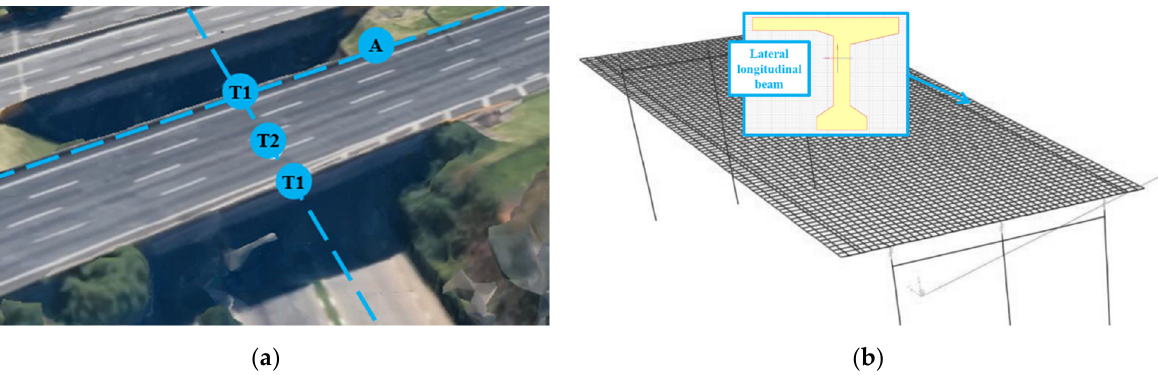
Figure 1. Brazilian bridge: ( a ) photo with the position of the sensors; ( b ) FEM model of the whole bridge and the lateral longitudinal beam [60].